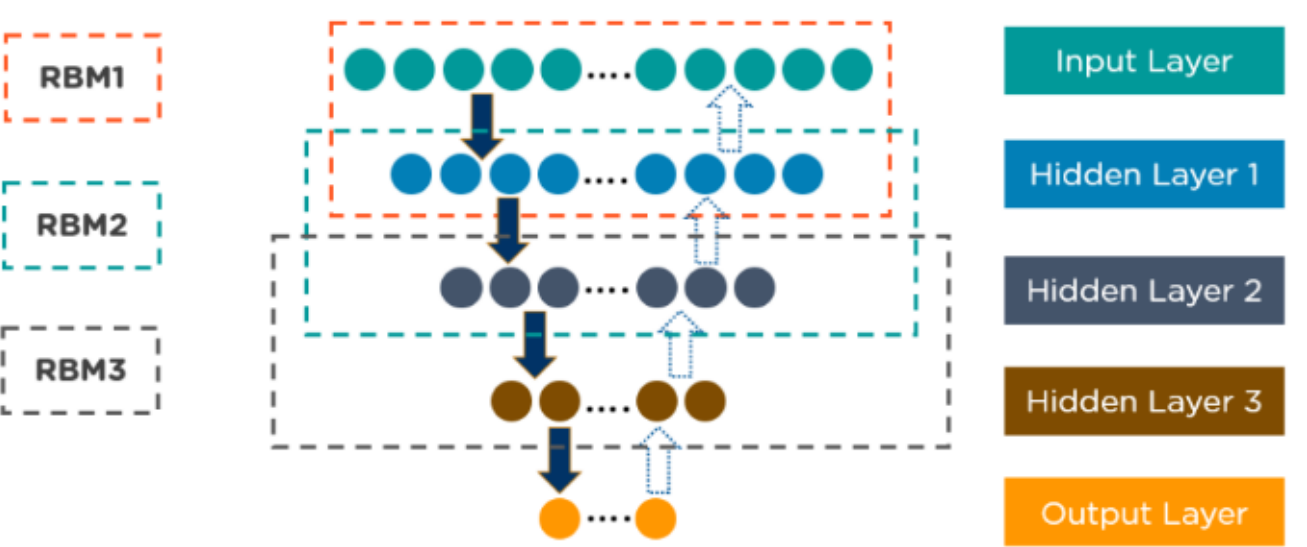
Figure 4. The developed DBN structure with multilayer RBM for the LCC prediction model.